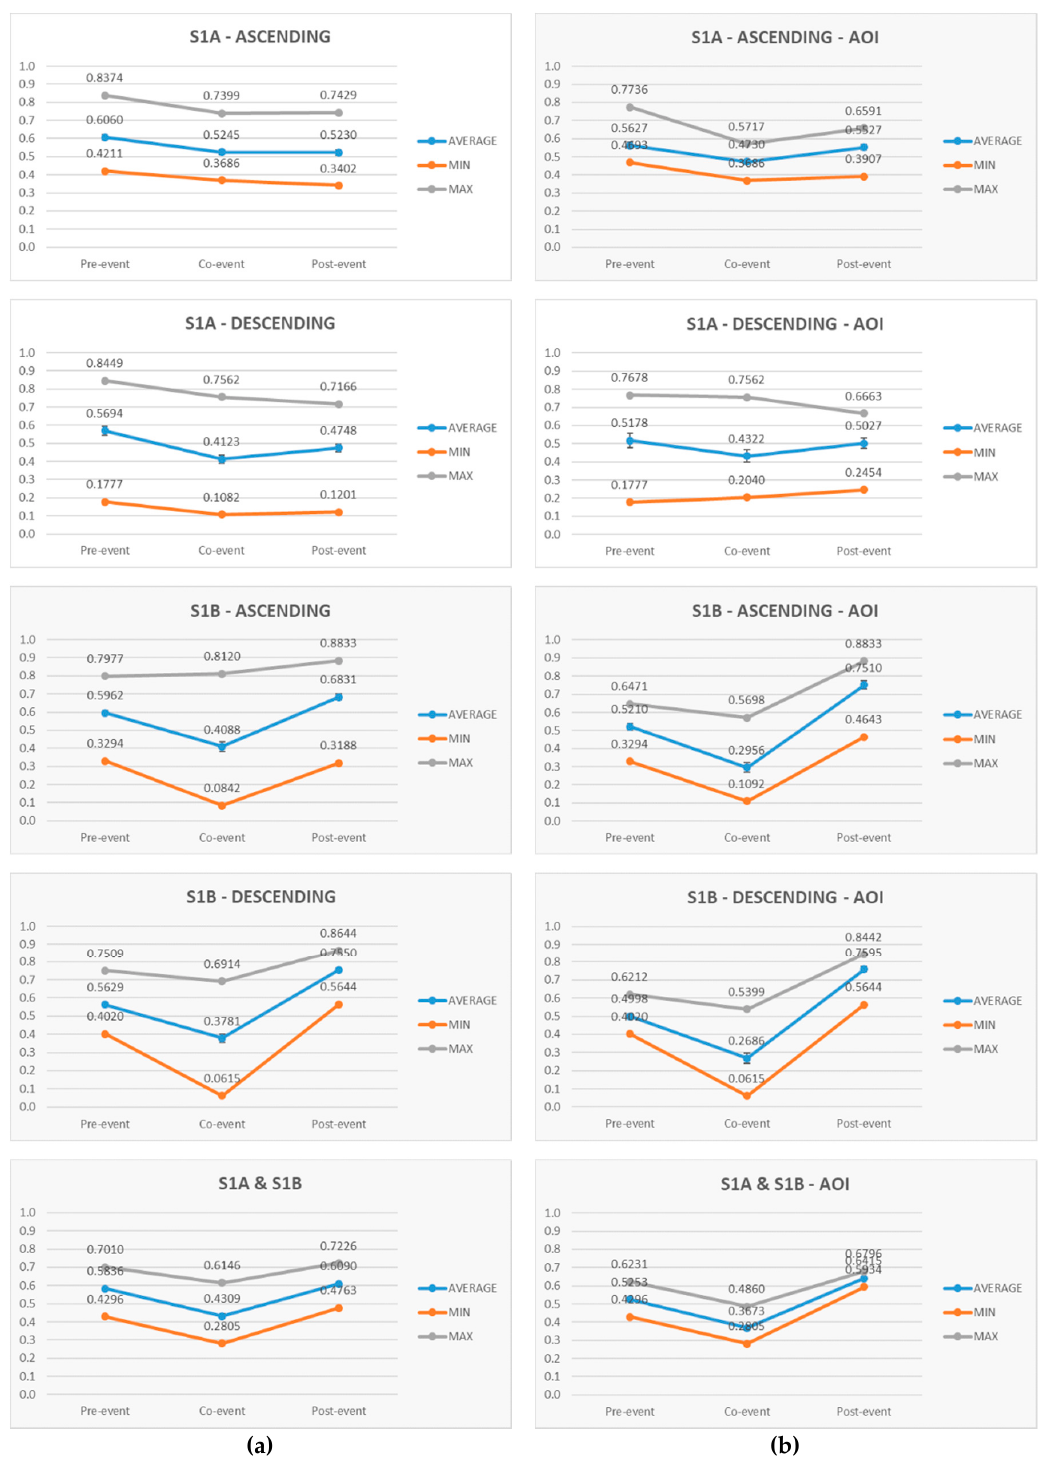
Figure 12. Coherence changes in the three periods for ( a ) the entire area and ( b ) the Area Of Interest (AOI). The minimum, maximum, and average coherence values obtained from Sentinel-1A and 1B ascending and descending based products as well as the overall average coherence values (min, max, and average) are presented during the pre-event, co-event, and post-event periods. The trend of the changes in coherence over time in average, minimum, and maximum values was similar after averaging the coherence values from all SAR pairs. This finding was intensified in